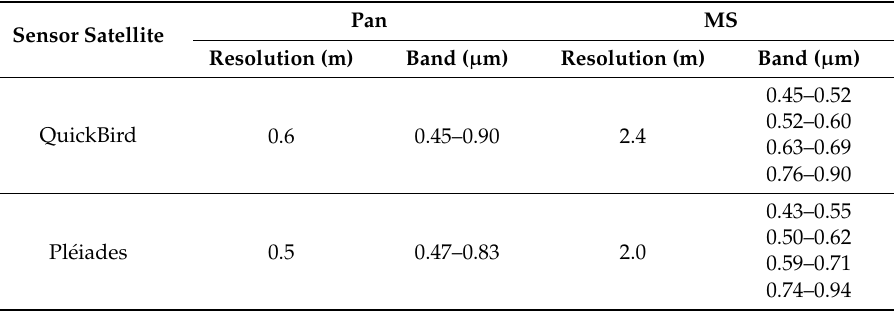
Figure 6. Experimental images and their corresponding ground-truth map: ( a ) study area; ( b ) test images; ( c ) ground-truth maps; and ( d ) magnified regions same as ground-truth maps. Table 2. Parameters of the satellite sensors.